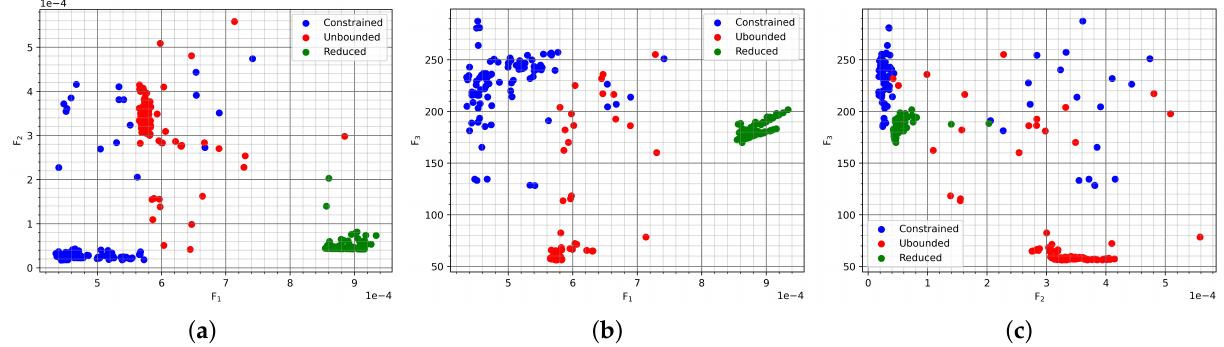
Figure 13. The image shows the last 100 symmetric solutions with various setups. The case where all 20 coils were free to move is in red. The blue color shows when all 20 coils are constrained in the 5.5–20 mm region, and finally, the green color depicts the case where only 12 coils are used, and they are constrained to the 5.5–20 mm region. ( a ) The distribution of the various setups on the F 1 – F 2 axis, ( b ) on the F 1 – F 3 axis, and ( c ) on the F 2 – F 3